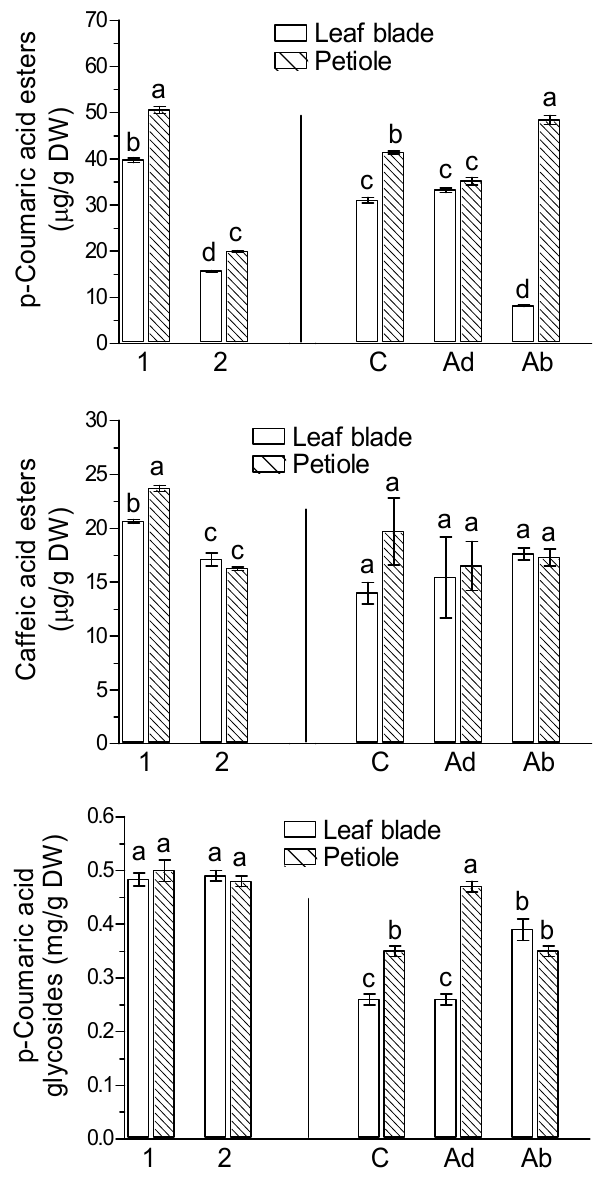
Figure 5. Effect of methyl jasmonate (JA-Me) on the content of phenolic acids in the leaf blade and petiole of G. biloba . Mean results ± SD followed by the same letter calculated for the natural senescence process and JA-Me treatment separately were not significantly different ( p < 0.05) according to Tukey’s test. Description of samples: 1, initial time (9 September); 2, naturally senesced yellow leaves (20 October); C, control (lanolin); Ad, JA-Me applied to the adaxial side of the leaf blade; Ab, JA-Me applied to the abaxial side of the leaf blade. C, Ad, and Ab samples were collected for analysis on 30